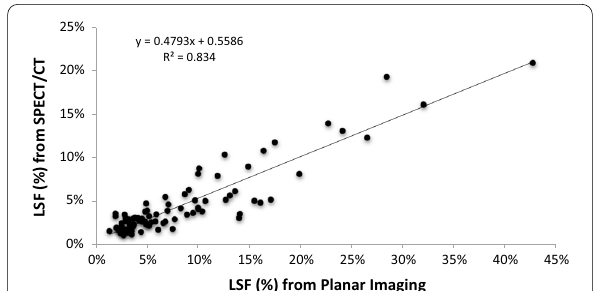
Fig. 2 Linear correlation between planar imaging vs. SPECT/CT derived LSF